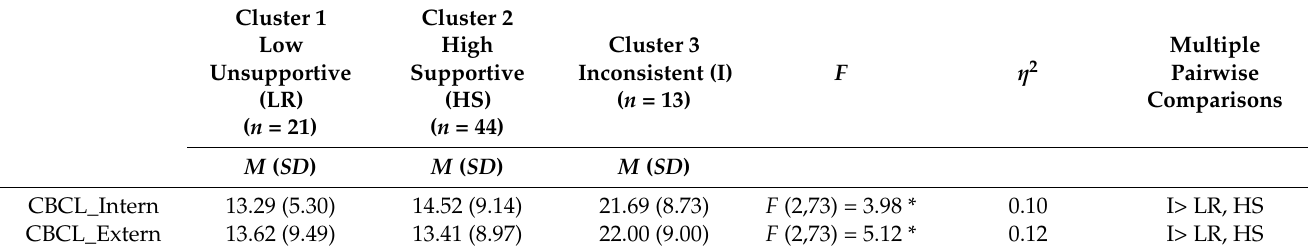
Table 4. Comparisons between clusters in relation to children’s internalizing and externalizing problems: means ( M ), standard deviations ( SD ), ANOVAs results, and multiple pairwise